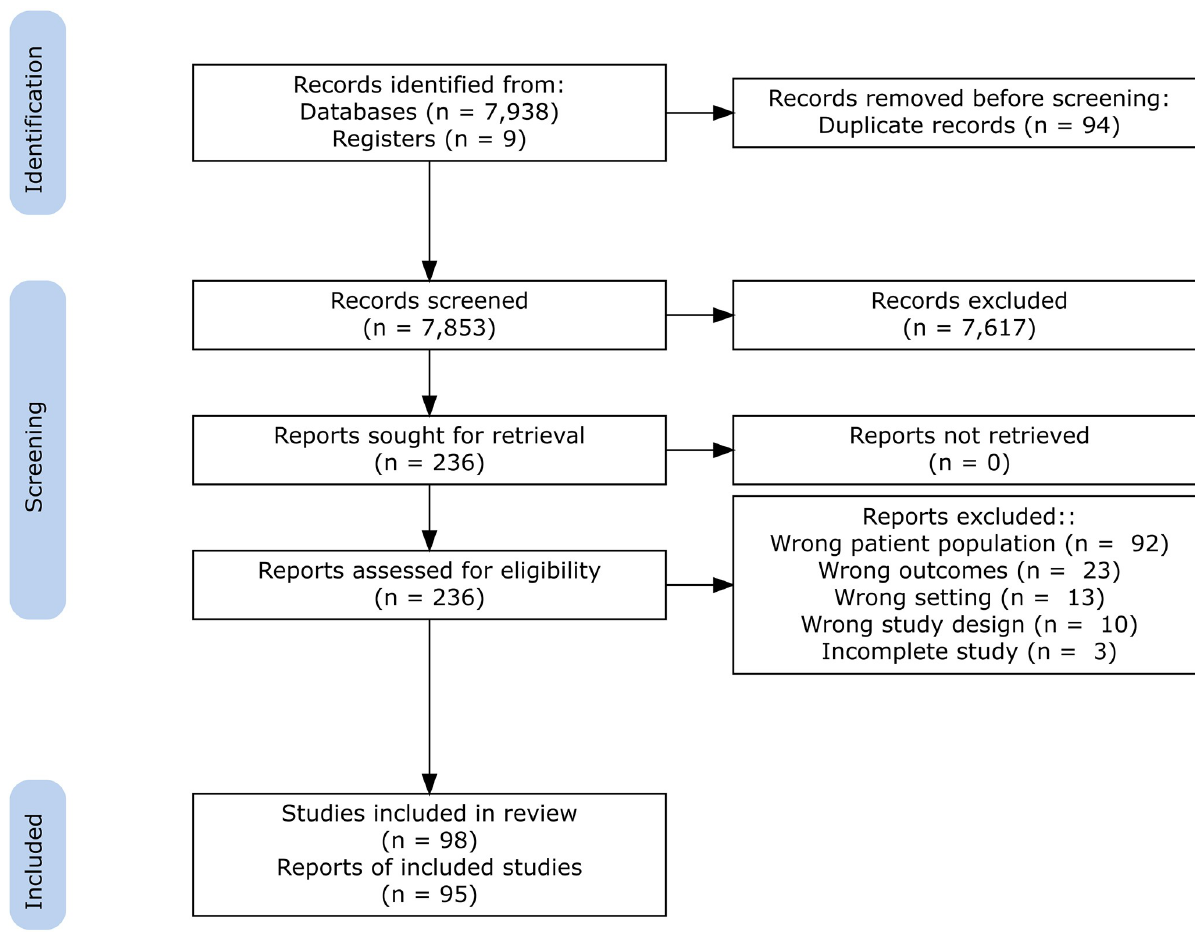
Fig 1. PRISMA flow chart showing the selection of studies included in systematic